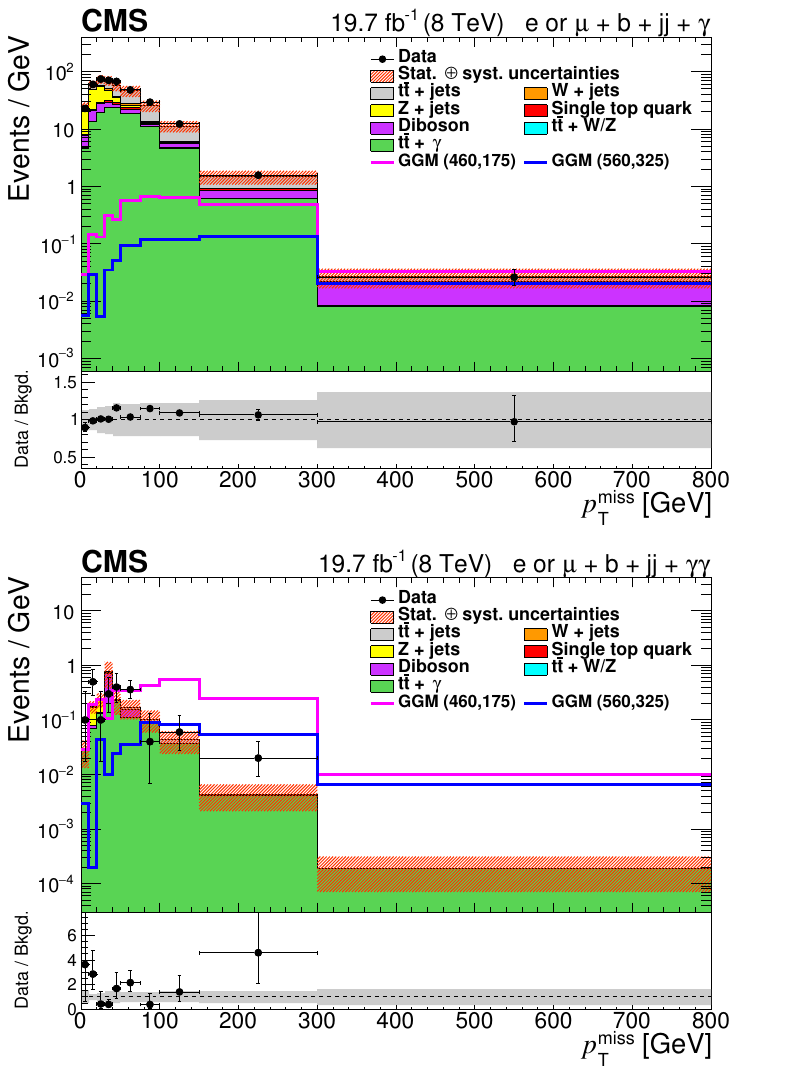
Figure 4 . Comparison of data and MC simulation in p miss (upper pane) SR1 with one reconstructed photon and (lower pane) SR2 with two reconstructed photons. Each bin is normalized by its bin